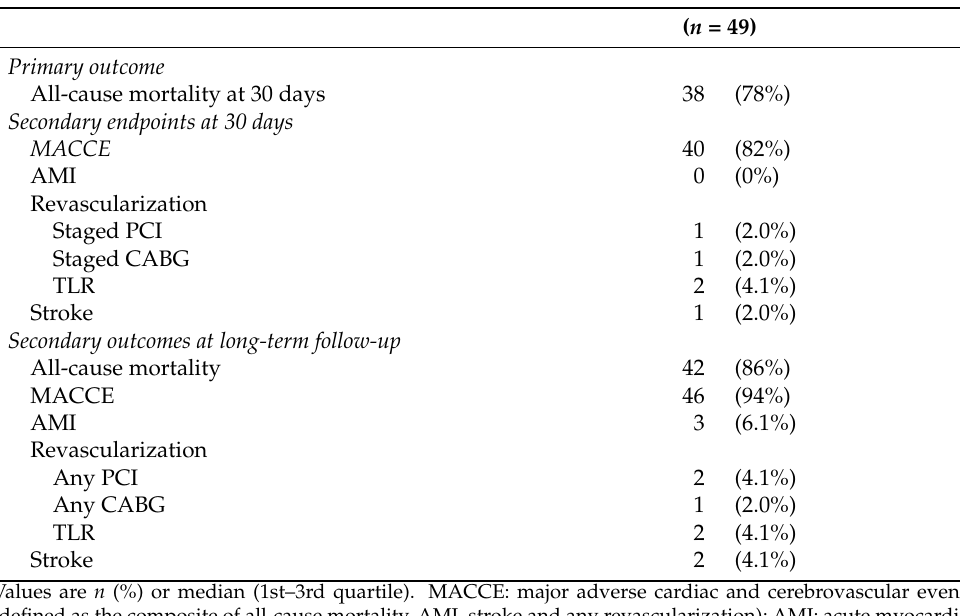
Table 3. Outcomes.